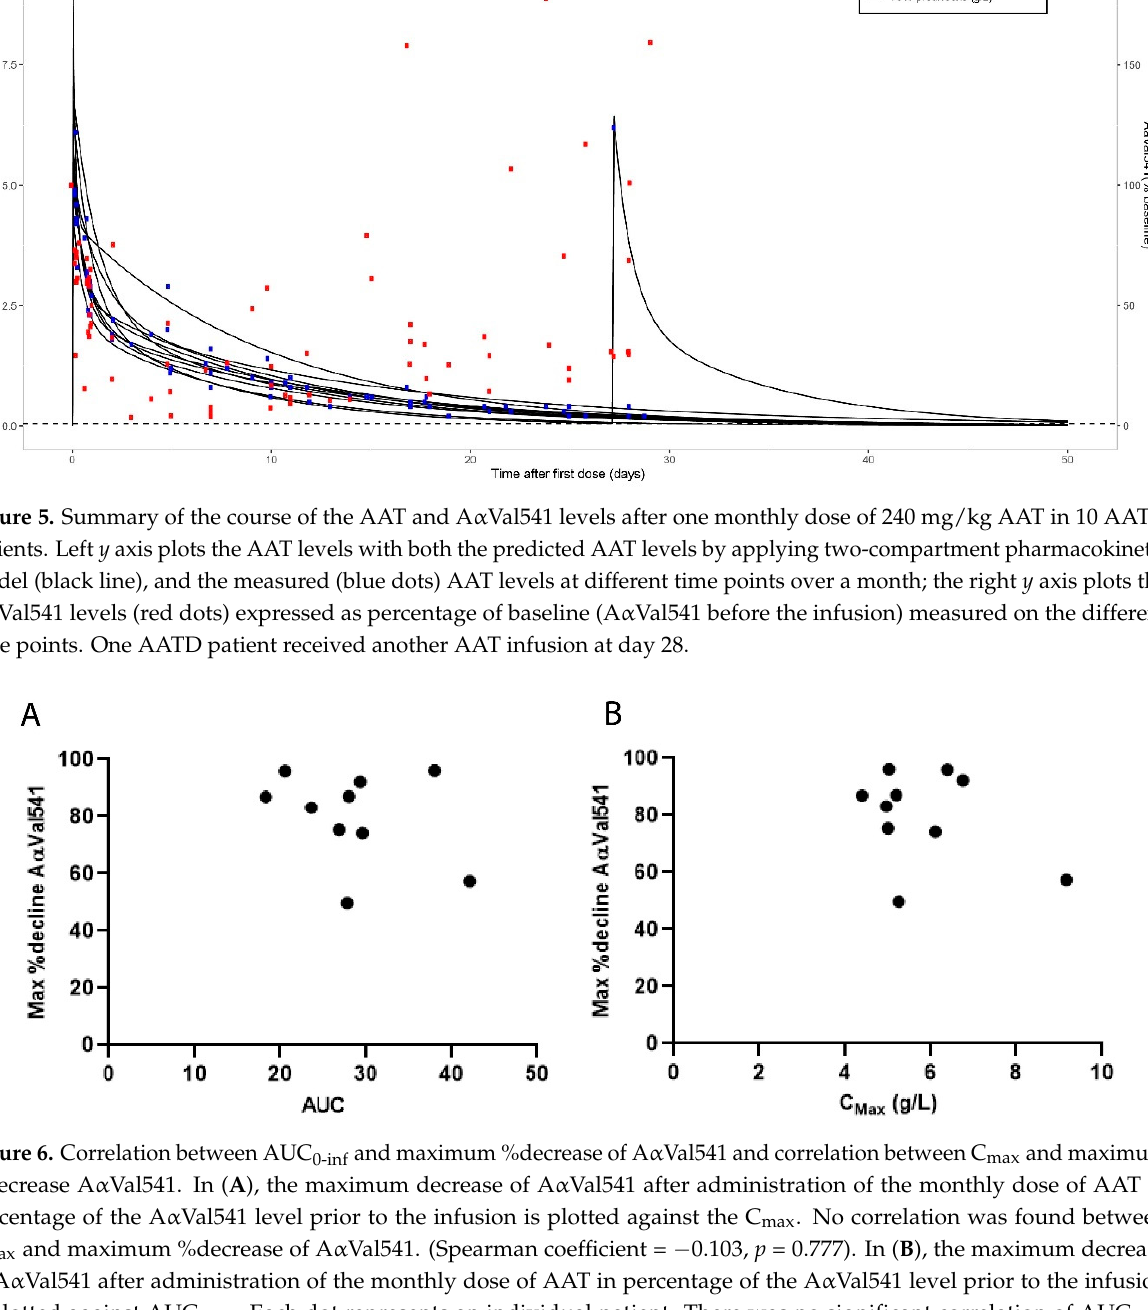
Figure 6. Correlation between AUC 0-inf and maximum %decrease of A α Val541 and correlation between C max and maximum %decrease A α Val541. In ( A ), the maximum decrease of A α Val541 after administration of the monthly dose of AAT in percentage of the A α Val541 level prior to the infusion is plotted against the C max . No correlation was found between C max and maximum %decrease of A α Val541. (Spearman coefficient = − 0.103, p = 0.777). In ( B ), the maximum decrease of A α Val541 after administration of the monthly dose of AAT in percentage of the A α Val541 level prior to the infusion is plotted against AUC 0-inf . Each dot represents an individual patient. There was no significant correlation of AUC 0-inf with the maximum %decrease of A α Val541 (Spearman coefficient = − 0.1273, p = 0.7330). Abbreviations: AUC 0-inf = area under the AAT plasma concentration-time curve from dose administration to infinity, C max = Peak plasma concentration of AAT in